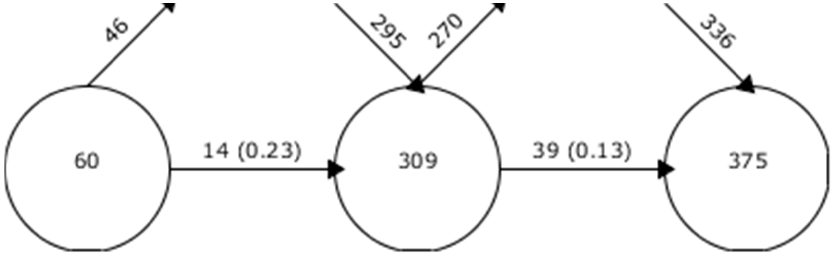
Figure 3. Continuity of keywords between contiguous intervals.